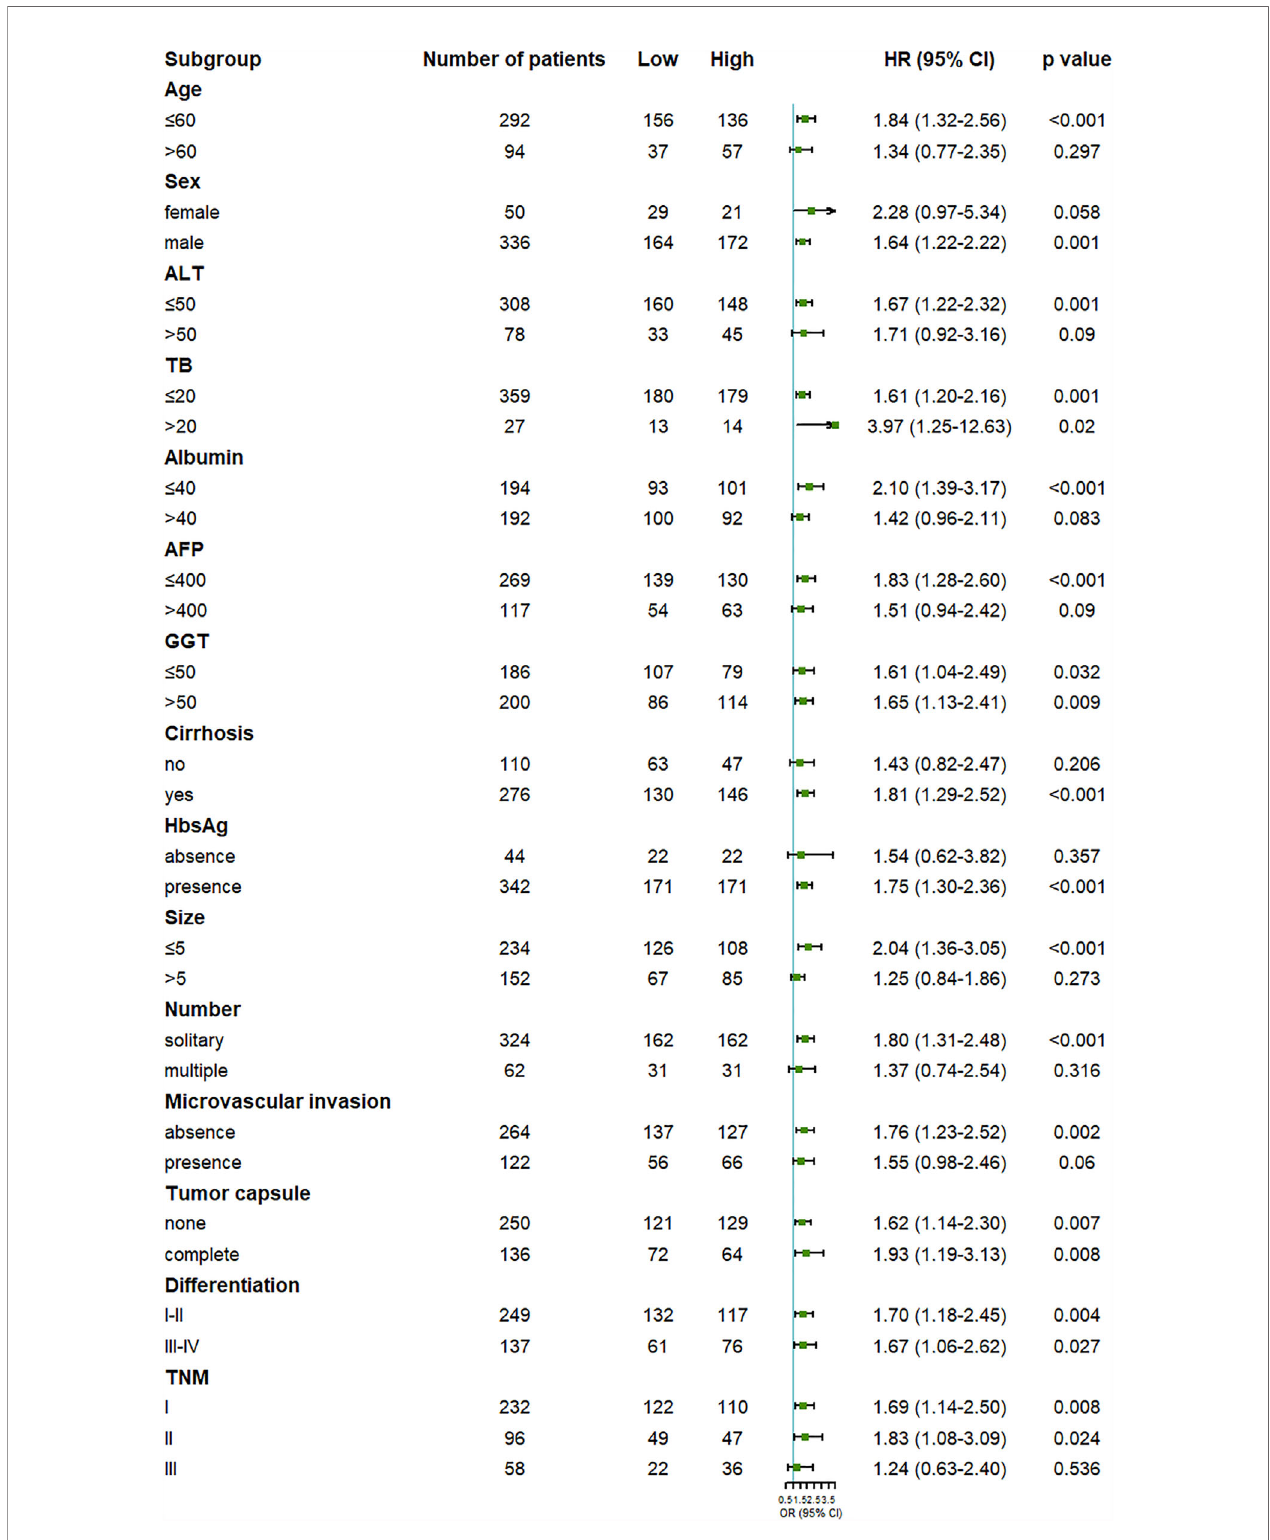
FIGURE 3 | Forest plot showing the effect of serum OPG levels on disease-free survival in HCC patients strati fi ed by different clinicopathological factors before matching. HR>1 and p<0.05 suggested that higher OPG levels in serum were associated with poorer survival outcome.